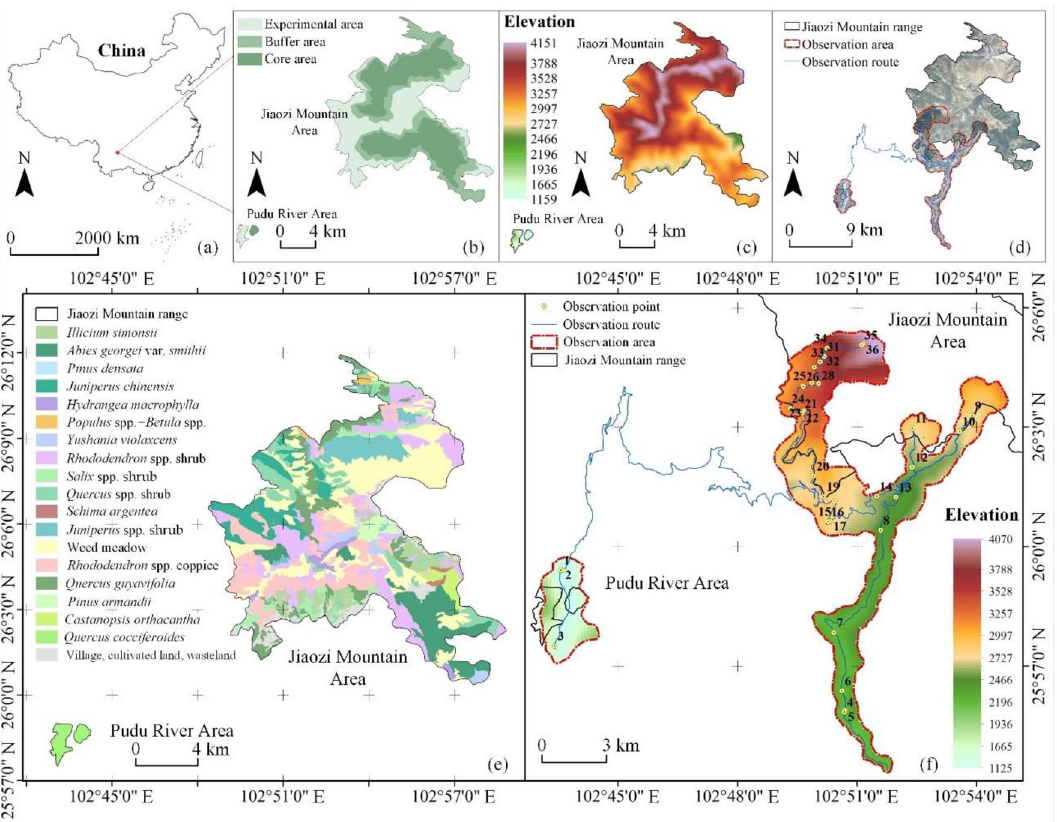
Figure 1. ( a ) The location in China of the study site, Jiaozi Mountain National Nature Reserve. ( b ) The protection classification within the Reserve. ( c ) Elevation distribution of Jiaozi Mountain. ( d ) Vegetation type distribution on Jiaozi Mountain. ( e ) Main vegetation types within the Reserve. ( f ) The study area boundaries and observation